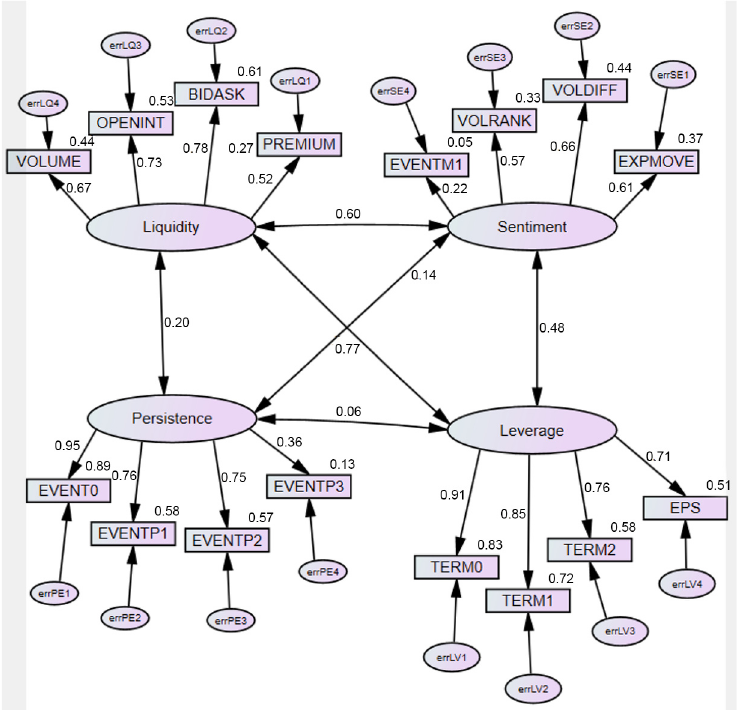
Figure 4. AMOS output path diagram for hypothesized